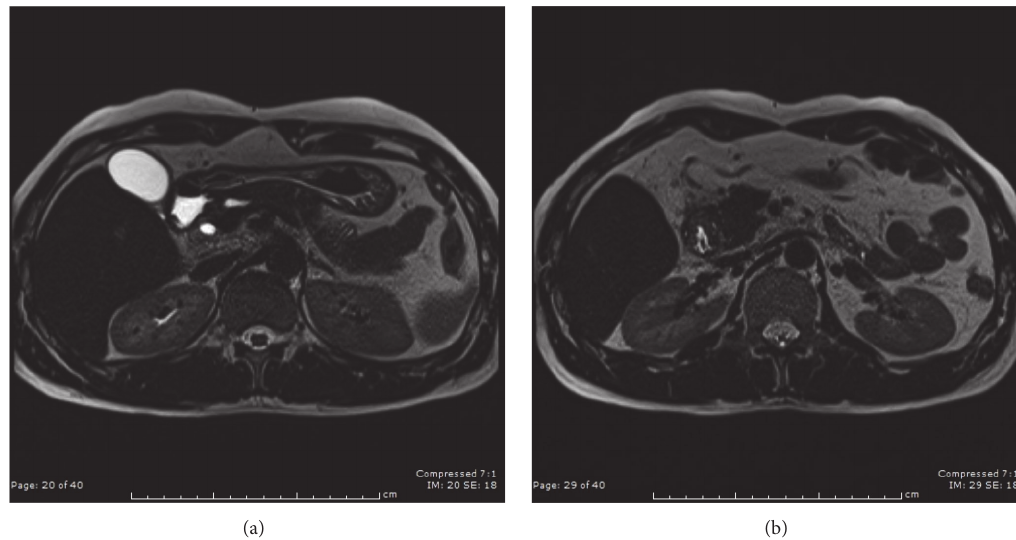
Figure 4: A follow-up MRI after 3 months of conservative treatment shows a nearly complete resolution of the duodenal